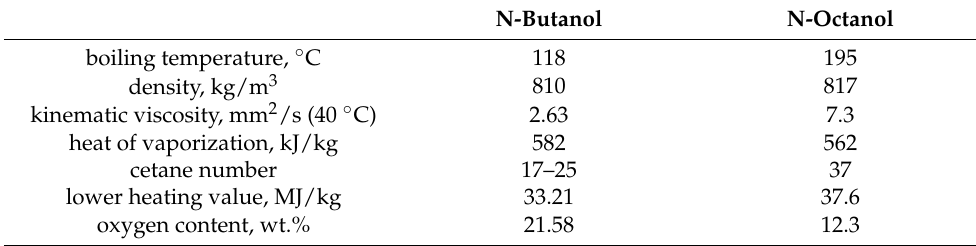
Table 3. Properties of n-butanol and n-octanol